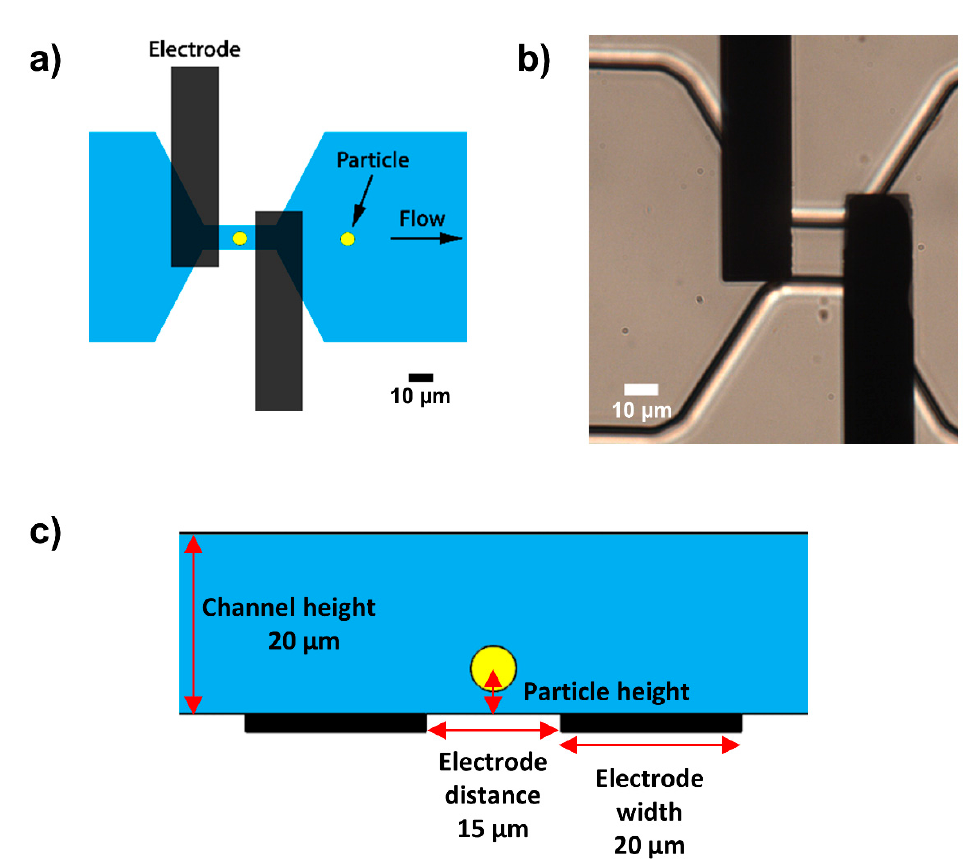
Figure 3. ( a ) Top view of the microfluidic chip showing the coplanar electrode pair and constriction channel to increase the sensitivity of the measurement. ( b ) Realization of the glass-PDMS chip with coplanar electrodes. ( c ) Side view of the chip with a channel height of 20 µm, electrode distance of 15 µm, and the particle height relative to the electrodes.